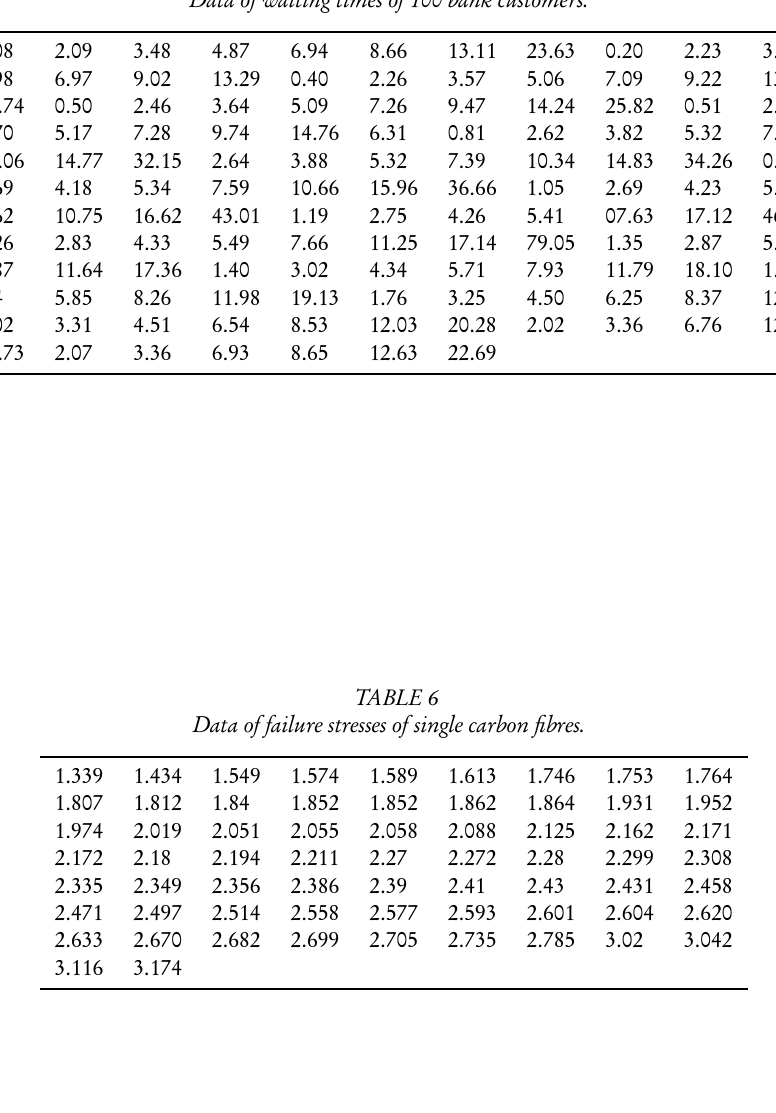
Data of waiting times of 100 bank customers.